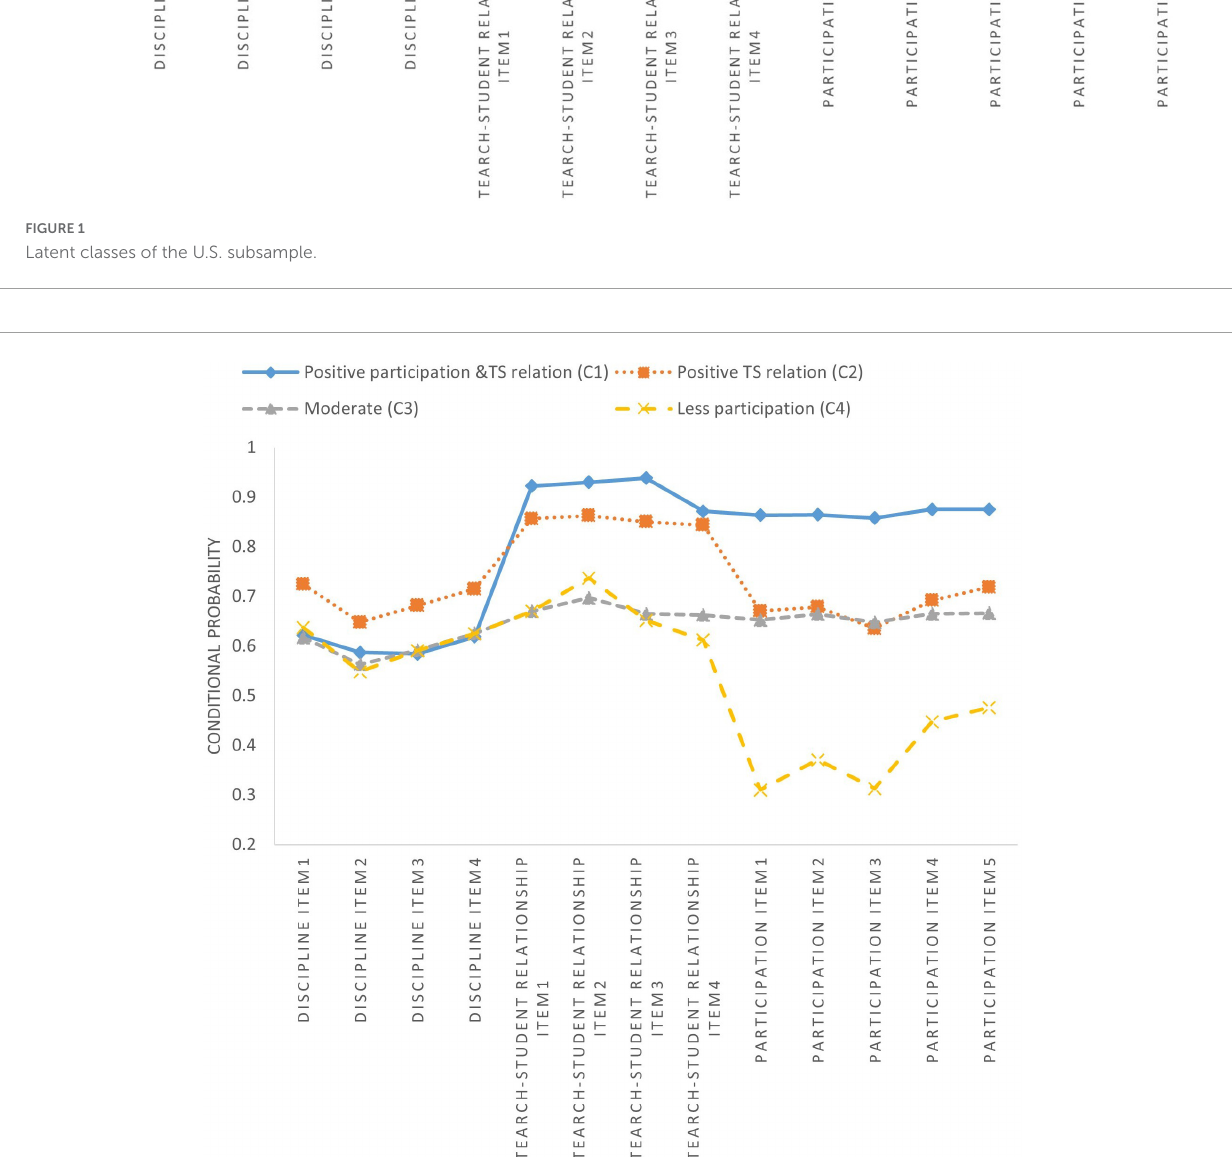
FIGURE2 Latent classes of the China